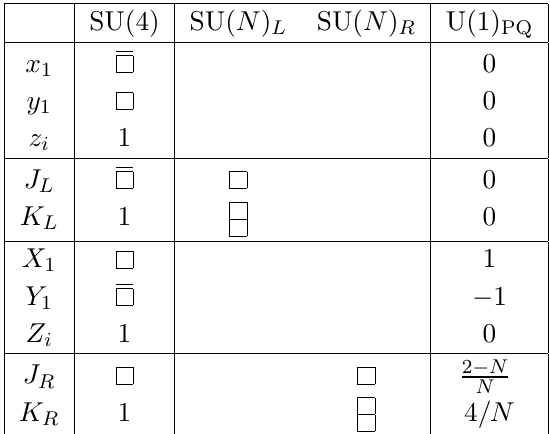
Table 2 . Operators describing infrared degrees of freedom in the con(cid:12)ned phase of SU( N ) ‘ SU( N ) r , and their transformation properties under the approximate SU( N ) L (cid:13)avor